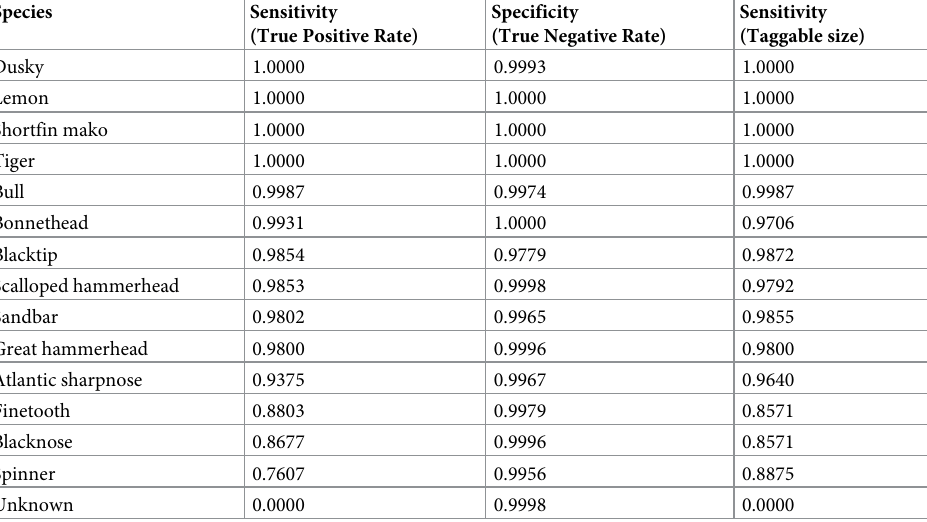
Table 3. Species sensitivity (TPR) and specificity (true negative rate [TNR]) for all sharks identified by anglers participating in TSR, 2014–2018. Sensitivity (TPR) is also reported for sharks of taggable size in the tournament (81.3 cm